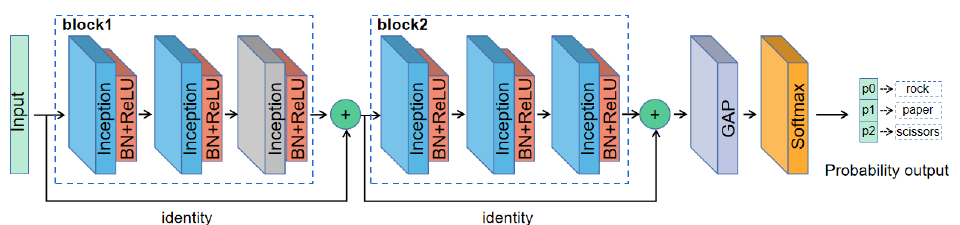
Figure 4. Inception network